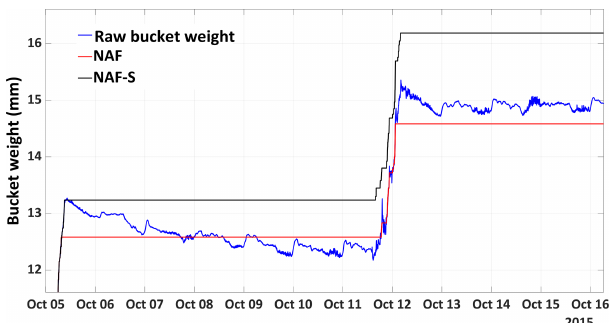
Figure 5. NAF (red) and NAF-S (black) precipitation data time se- ries data processing example compared to the Gaussian filtered raw bucket weight (blue). Data excerpt is from an actual precipitation time series observed at XBK in October